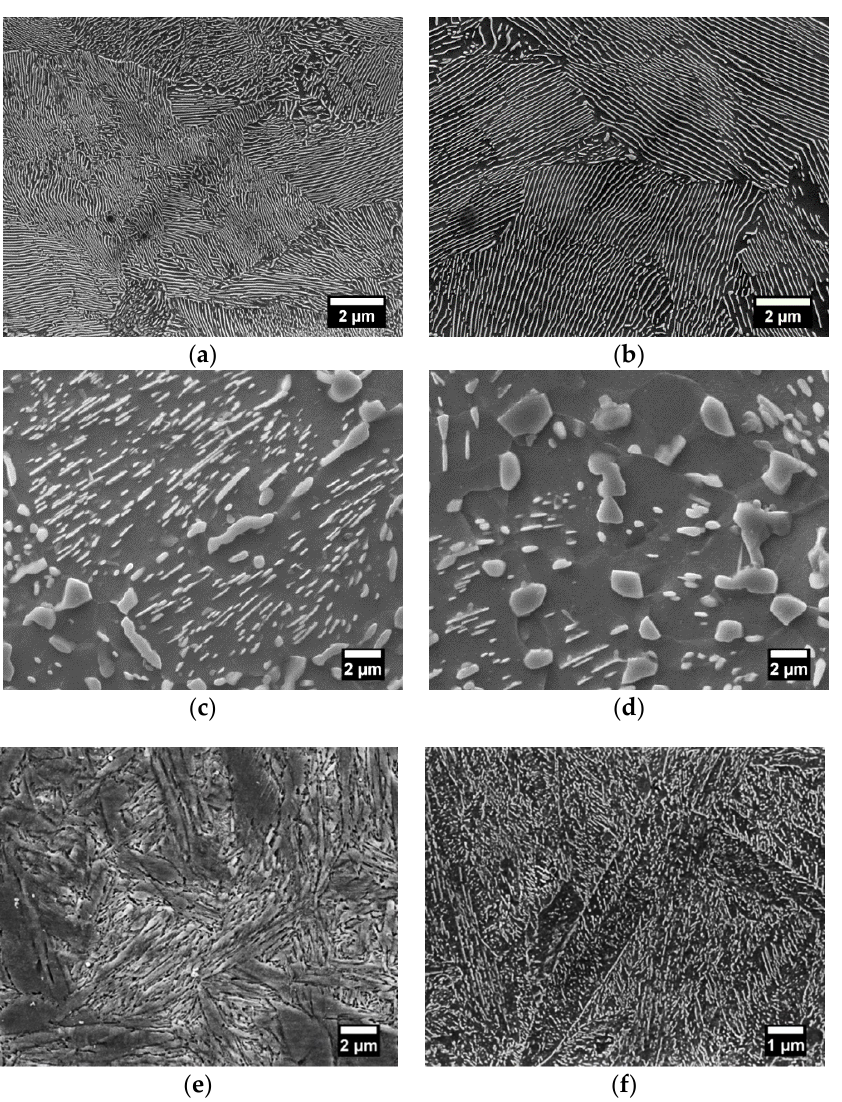
Figure 9. FE-SEM images of ( a ) fine and ( b ) coarse lamellar pearlite; ( c , d ) spheroidite at different stages of spheroidization; ( e ) martensite; ( f ) tempered martensite microstructures obtained from AISI 1080 steels.